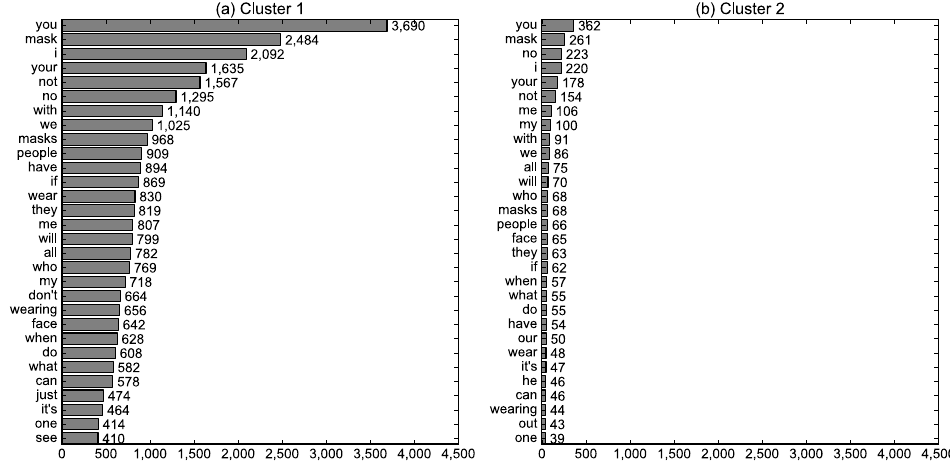
Table 2. The mean comparison of facial features between clusters of the Instagram photos with a #NoMask hashtag.